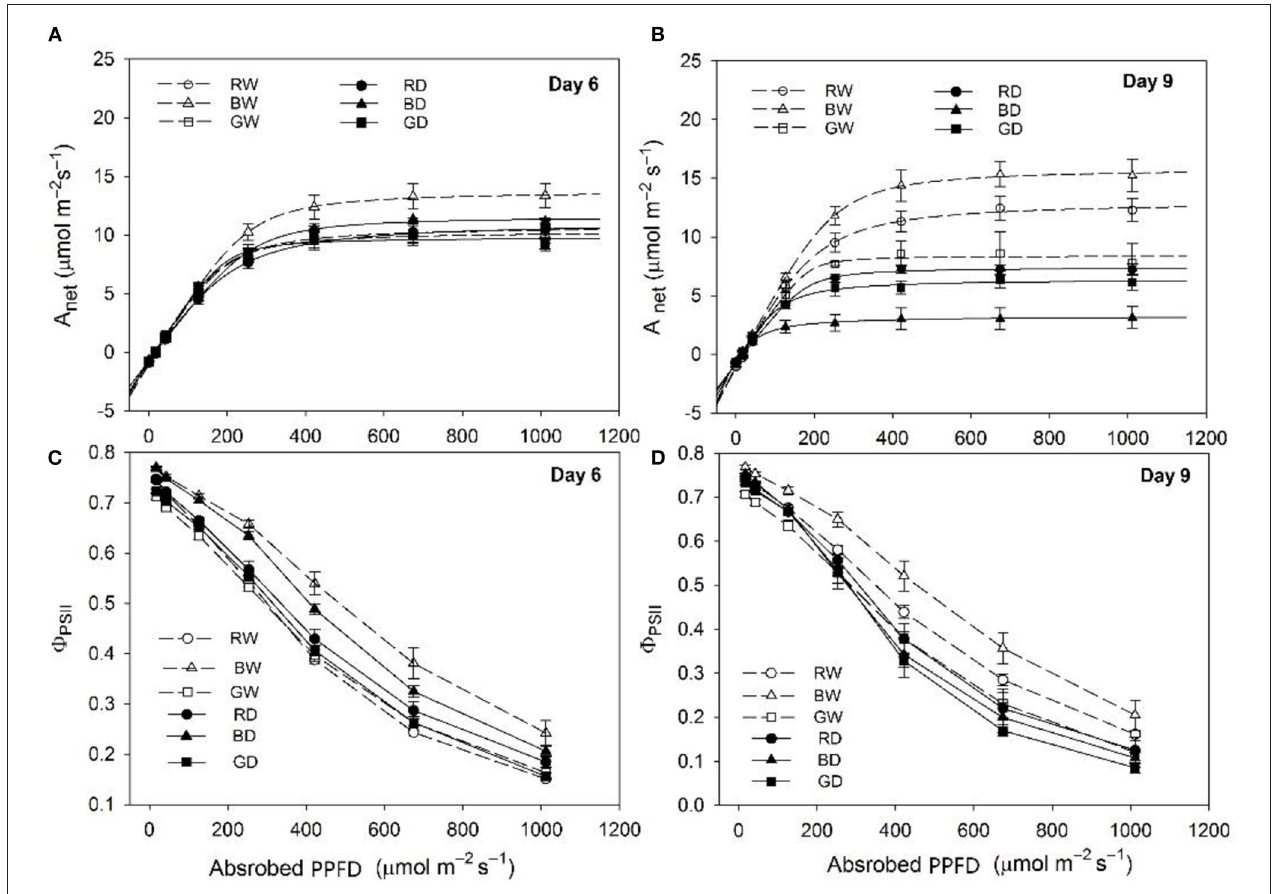
FIGURE 1 | The photosynthetic response of tomato seedlings under different water and spectral conditions. (A,B) , the changes of net photosynthetic rate (A net ) to increased light intensity; (C,D) , the changes of photosystem II (PSII) quantum efficiency ( φ PSII ). RW, BW, and GW: well-water combined with red, blue, and green LED light, respectively; RD, BD, and GD: drought stress combined with red, blue, and green LED light, respectively. The photosynthetic photon flux density (PPFD) for all the treatments was 200 µ mol m − 2 s − 1